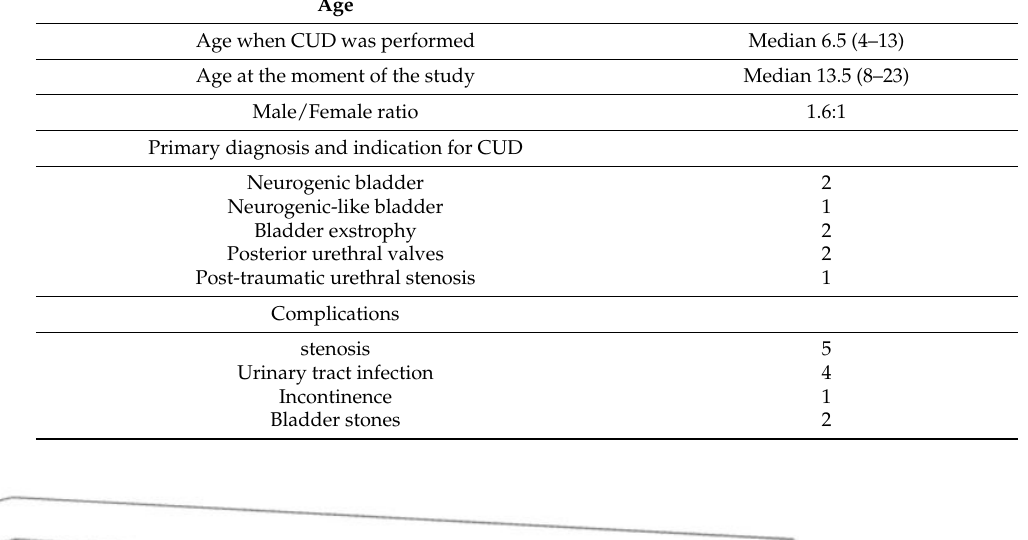
Table 2. Patients included in our study.